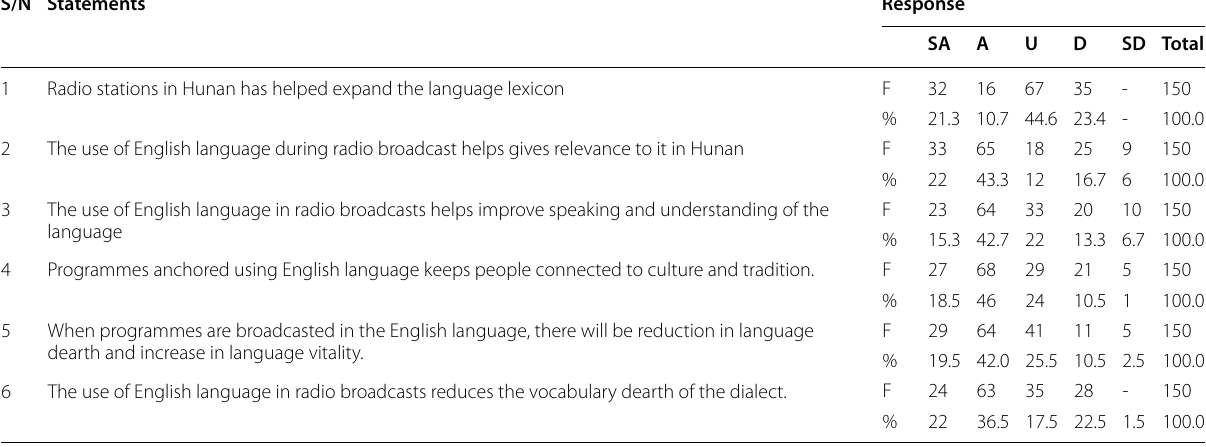
Table 11 Frequency, percentage on statement regarding the roles of radio broadcast media in the management of multilingualism in Hunan (Audience